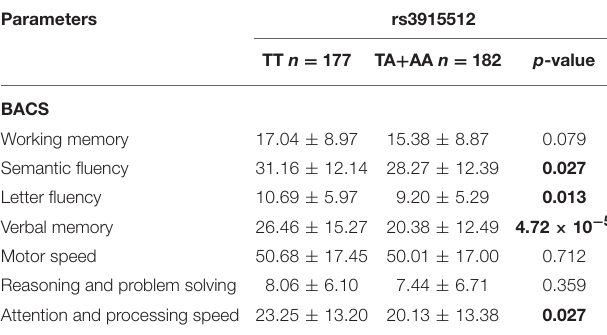
TABLE 3 | Neurocognitive functions of the patients with schizophrenia and distribution by genotypes of the